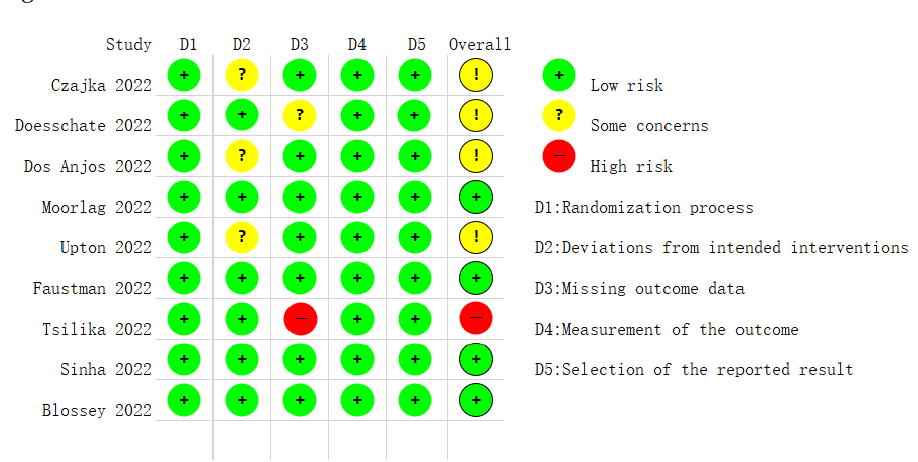
Figure 6. Quality assessment of the risk of bias in the studies.